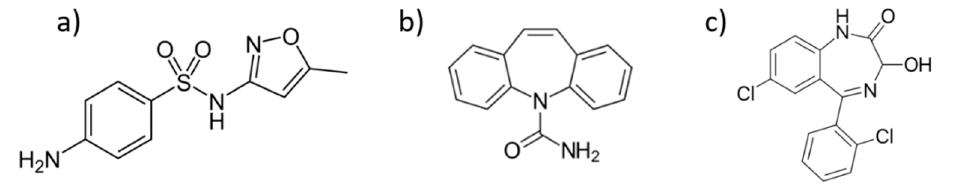
Figure 1. Molecular structure of ( a ) sulfamethoxazole, ( b ) carbamazepine and ( c ) lorazepam.